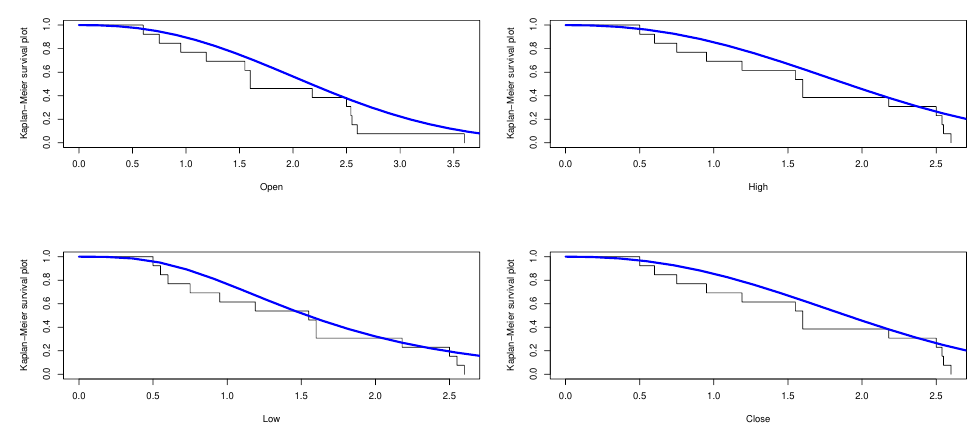
Figure 7. The Kaplan–Meier survival function of the E-WD.